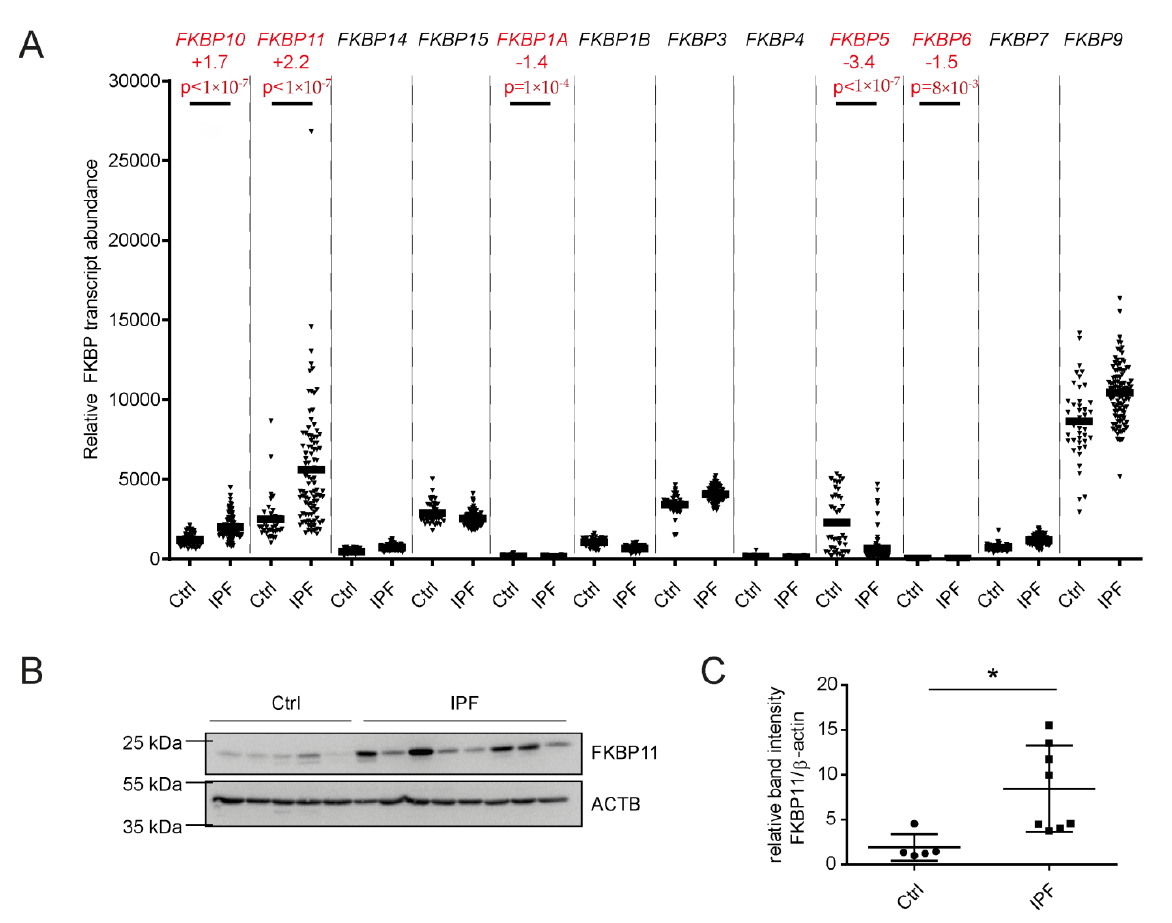
Figure 1. FKBP11 is upregulated in idiopathic pulmonary fibrosis (IPF). ( A ) Scatter plot for FKBP gene expression data extracted from microarray data of normal histology control ( n = 43) and samples from patients with IPF ( n = 99) [50,51]. ( B ) Western blot analysis of total lung tissue homogenate showed upregulation of FKBP11 in patients with IPF ( n = 8) relative to donor samples ( n = 5). ( C ) Densitometric analysis of the Western blot from ( B ). For Western Blot analysis, data shown are mean ± SEM, and a two-tailed Mann-Whitney test was used for statistical analysis (* p < 0.05). ACTB = β -actin as loading control.